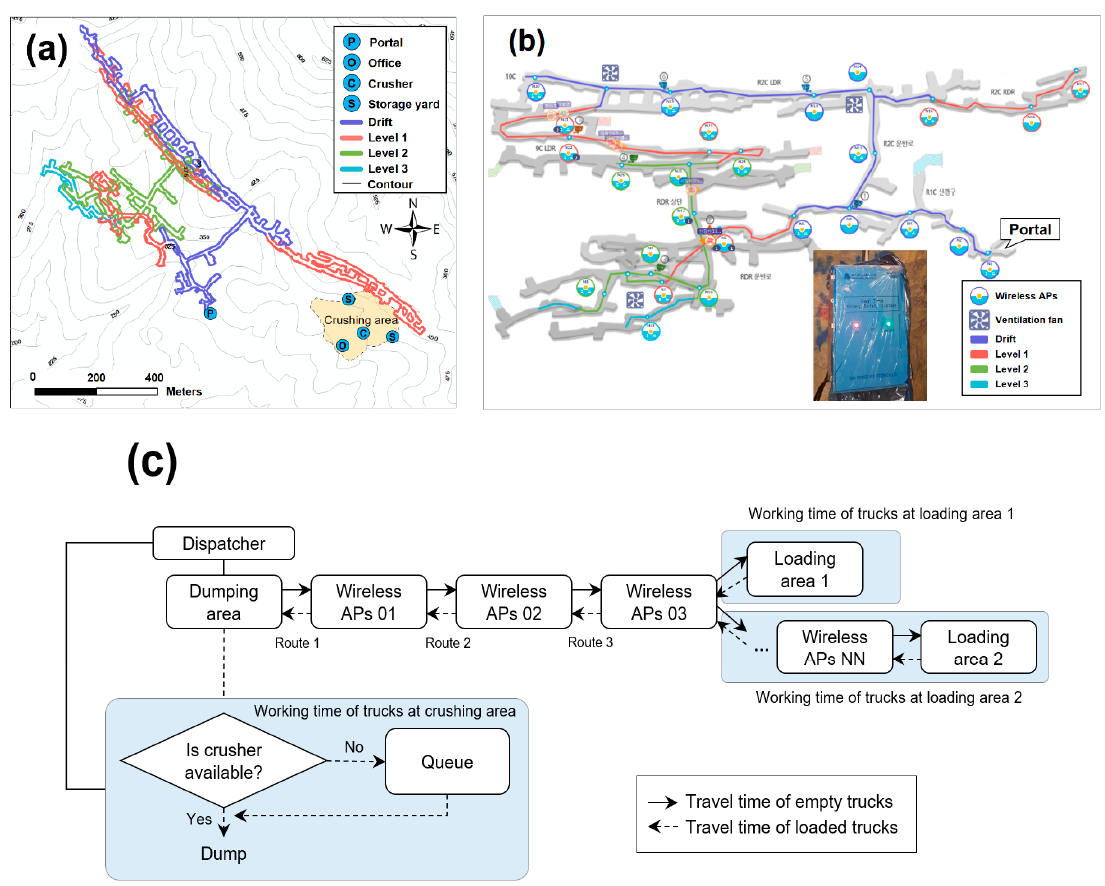
Figure 1. Schematics of study area: ( a ) mine map indicating underground drifts and outside crushing area; ( b ) location map of wireless APs along haulage road in underground mine; ( c ) process of haulage operation system.